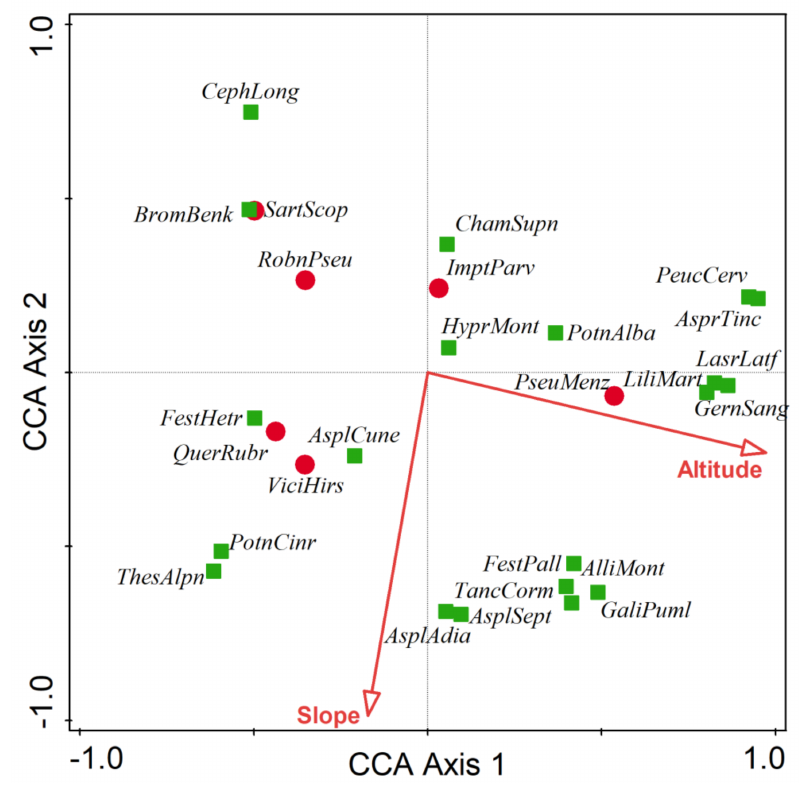
Figure 5. CCA distribution diagram of alien (red circles) and rare/endangered species (green squares) recorded in serpentine forest communities in SW Poland. Species scores limit to 26 by weight. Abbreviations of species names are in accordance with these presented in Tables 2 and